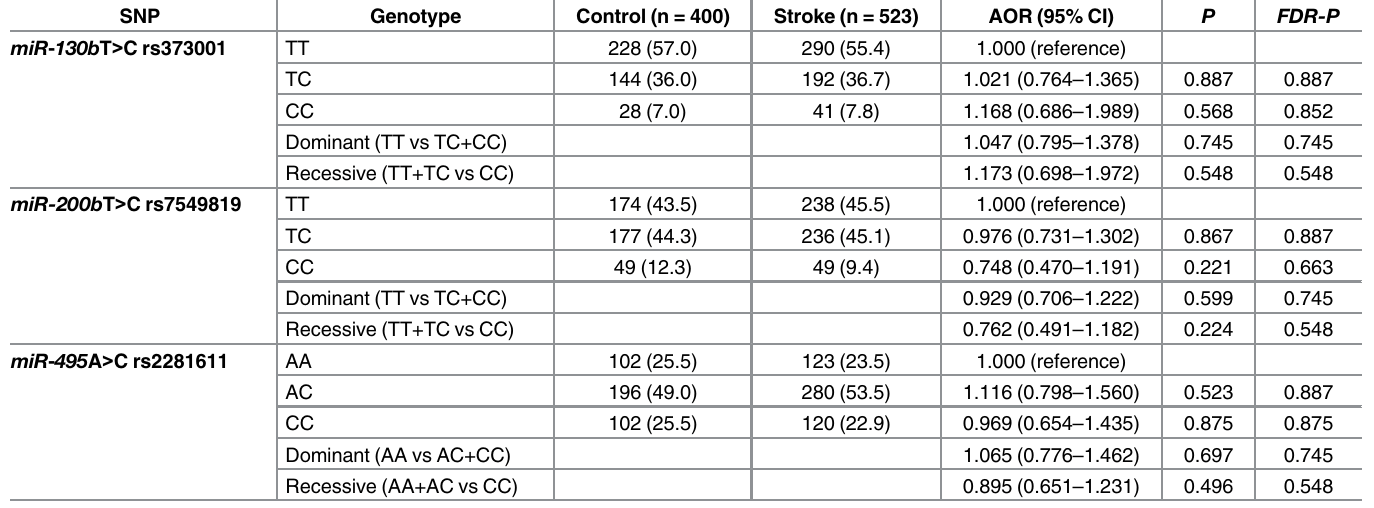
Table 2. Genotype frequencies of microRNA gene polymorphisms in controls and ischemic stroke